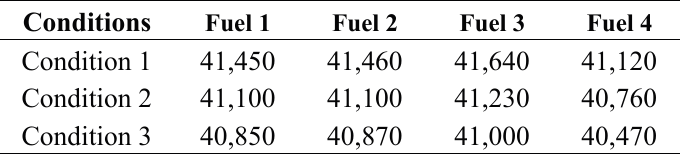
Table 2. Engine RPM for different fuels at different